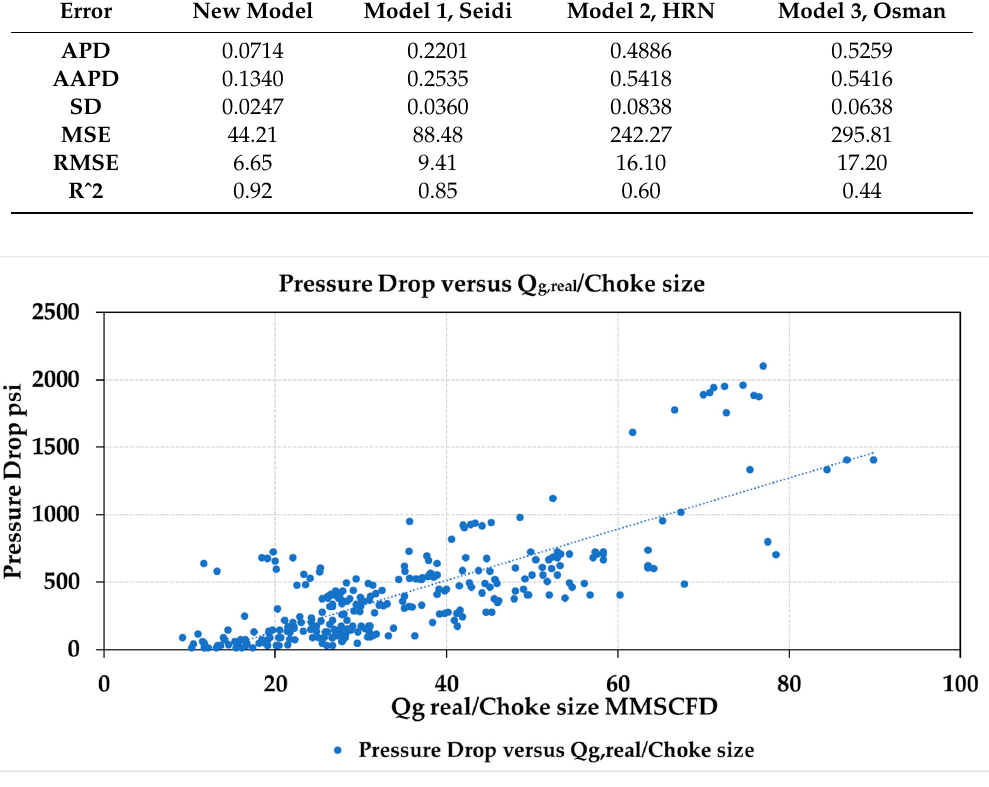
Figure 4 . Pressure drop across the choke vs flow rate per choke size . Figure 4. Pressure drop across the choke vs flow rate per choke